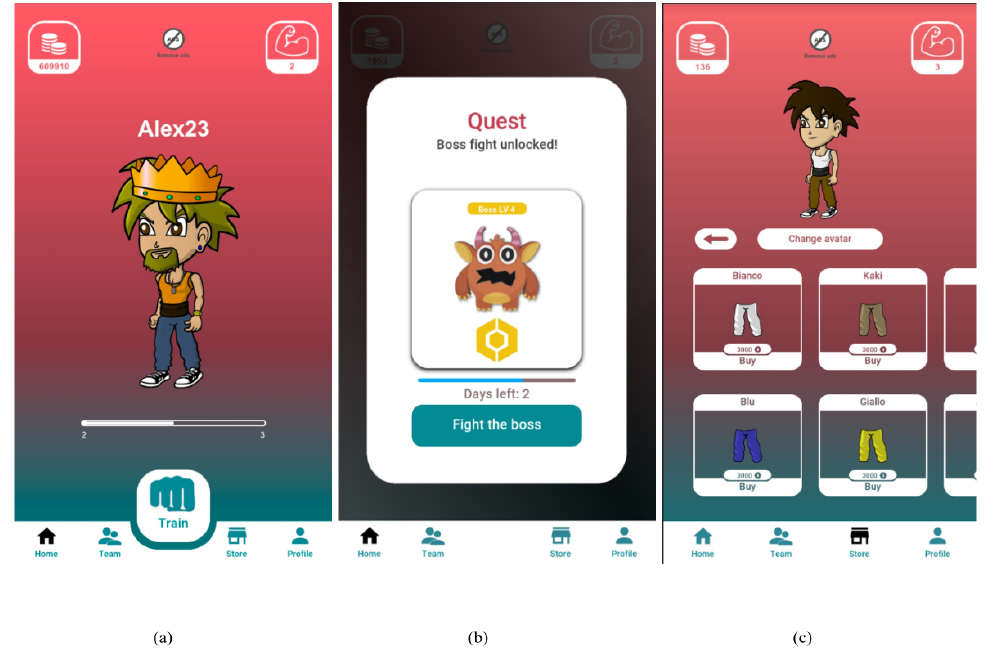
Figure 3. Screenshot of the app: Complete Version (F). ( a ) the app homepage, where at the bottom bar there is a shop icon, ( b ) the unlocking of the boss fight, ( c ) the shop section, where the user can exchange coins with virtual